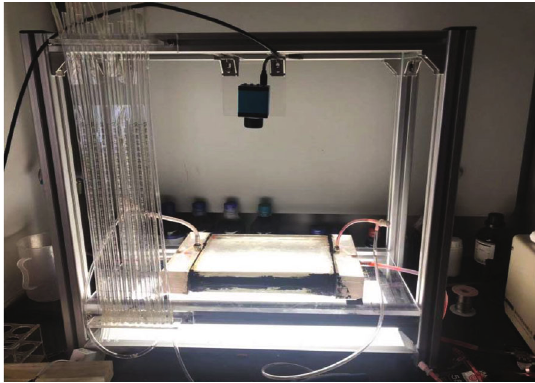
Figure 4: Main part of experimental